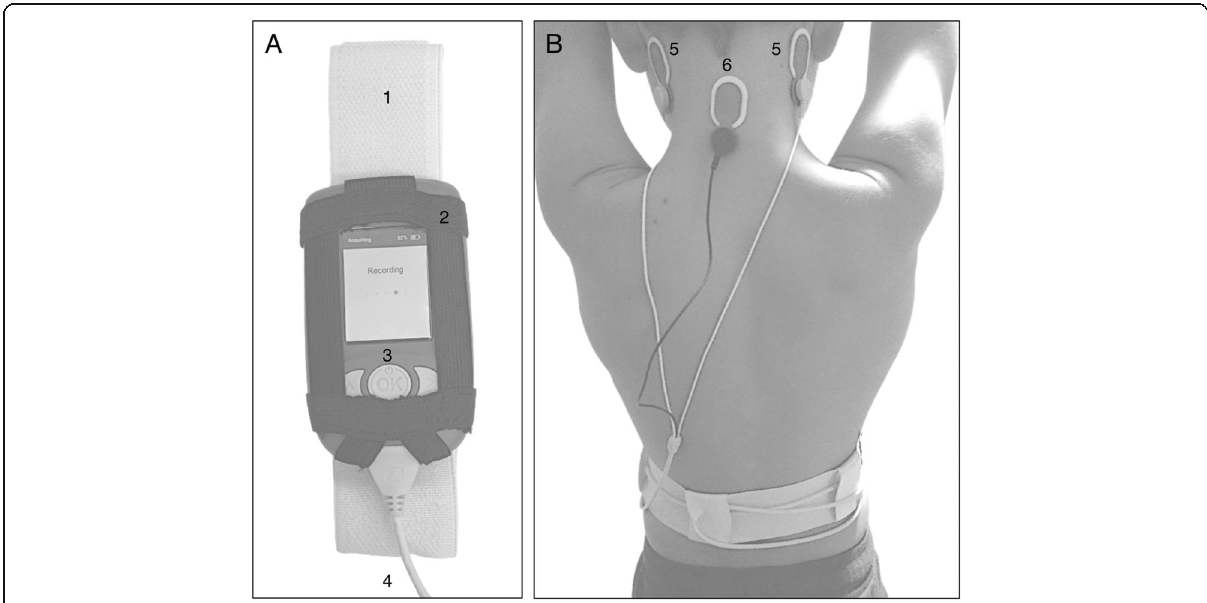
Fig. 2 Sleep assessment set-up. Image A shows the elastic belt (1), the custom-made elastic pocket (2), the Zmachine (3) and the cable from the Zmachine (4). Image B shows the signal sensors at the differential mastoids (5) and the ground sensor on the middle of the neck